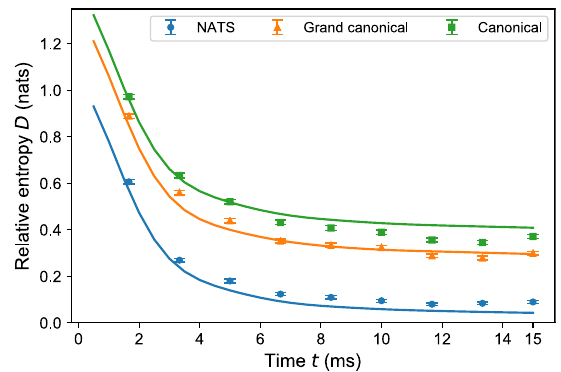
FIG. 2. The average distance from the system-of-interest state to the thermal prediction versus time. The ion chain consists of N = 21 qubits. Each nearest-neighbor pair forms a small system of interest. We measure the distance of the state to the NATS (blue points), using the relative entropy [8], and average over the pairs in the chain. The markers show experimental data, while the lines are calculated numerically from Eq. (3). Each data point is formed from 250 repetitions. The error bars are estimated by bootstrapping [66]. The entropies are measured in units of nats (are to base e ). We also compare the NATS pre- diction with two competitor thermal predictions, following